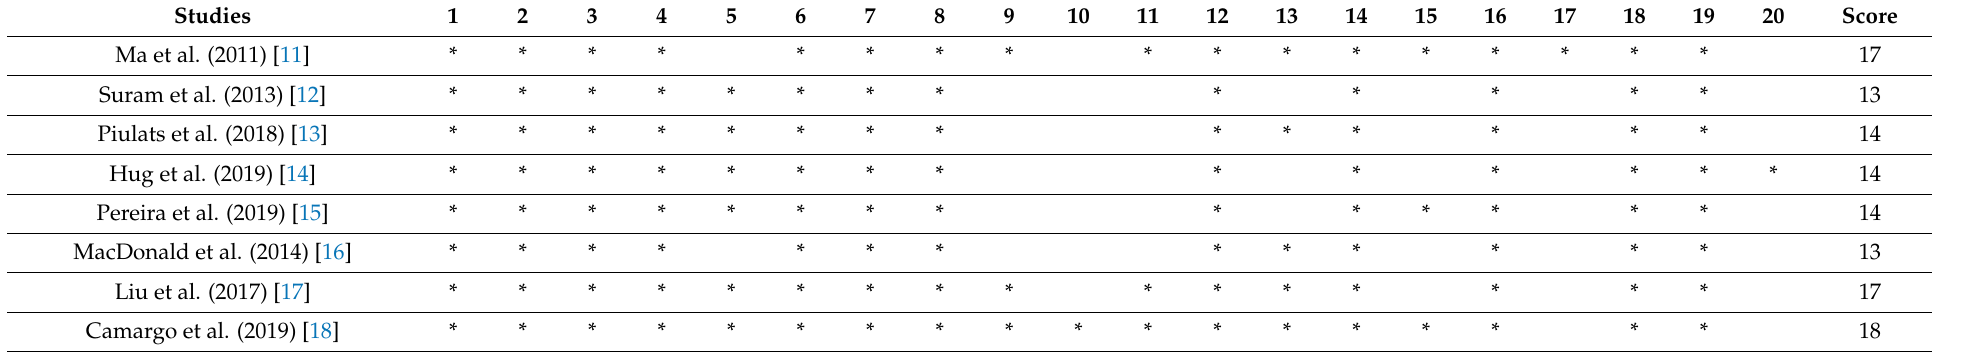
Table 2. Quality of articles assessed with the ARRIVE guideline for in vivo